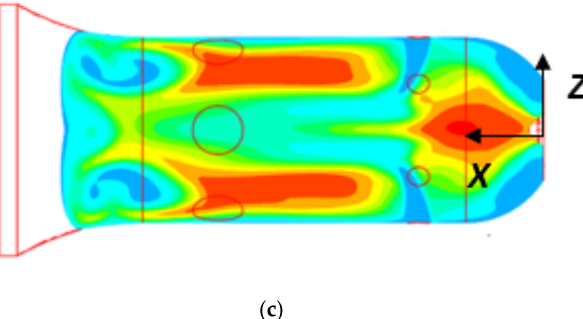
Figure 4. Time-averaged temperature contours on the horizontal midplane of the combustor ( y = 0 mm): ( a ) SSTKW, ( b ) RSM, ( c ) SSTKWSAS.